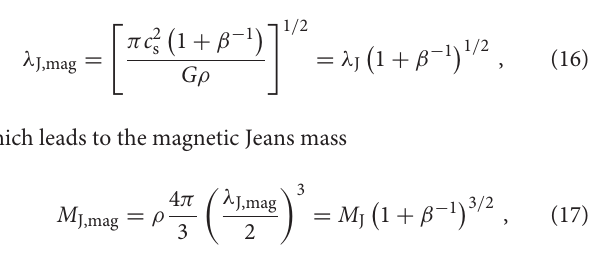
) is much less well-constrained, ⊙